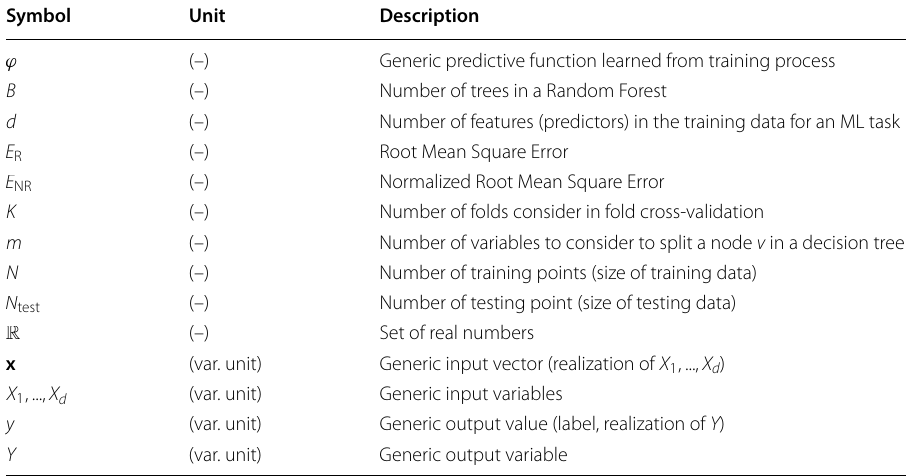
Table 12 Detailed nomenclature for machine learning-related variables